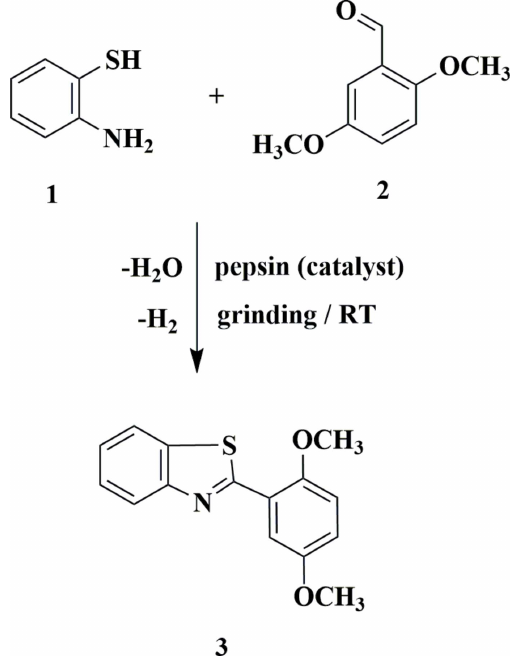
(Table 2), which links molecules via the c- glide operator x ,